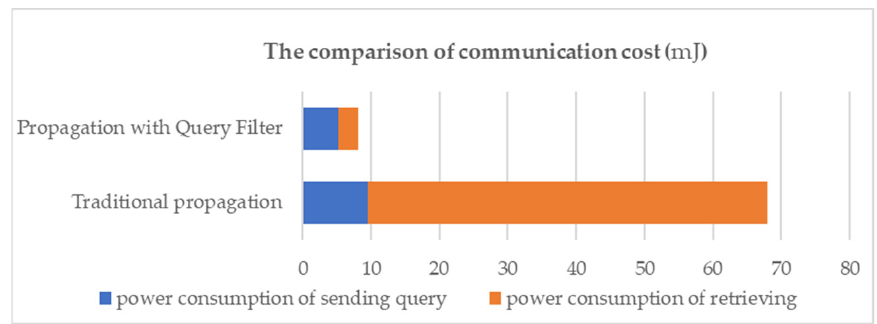
Figure 9. The power consumption of query with and without a query filter .